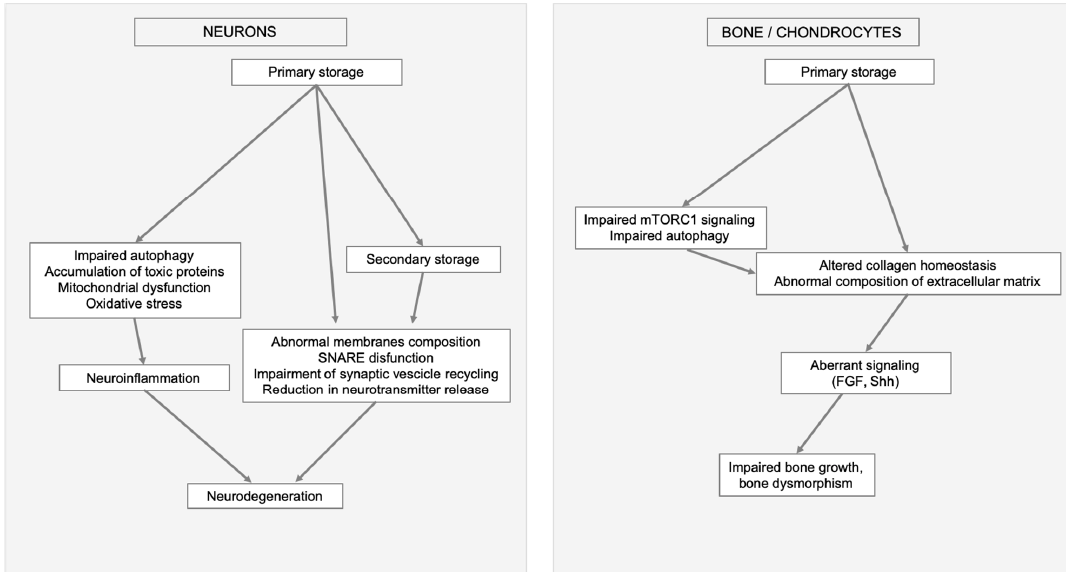
Figure 2. Examples of MPSs clinical manifestation triggered by primary storage and linked to secondary cellular impairments and altered signaling. In neurons and brain (left) impaired autophagy, mitochondrial dysfunction, oxidative stress, and secondary storage cause neuroinflammation, abnormal membranes composition, soluble N-ethylmaleimide-sensitive factor attachment protein receptors (SNARE) disfunction, impairment of synaptic vesicle recycling, and reduction in neurotransmitter release ultimately leading to neurodegeneration. In bone (right) secondary events, like aberrant mammalian target of rapamycin complex 1 (mTORC1) signaling, impaired autophagy, altered collagen homeostasis, abnormal composition of extracellular matrix e aberrant signaling, result in impaired bone growth and bone dysmorphism.